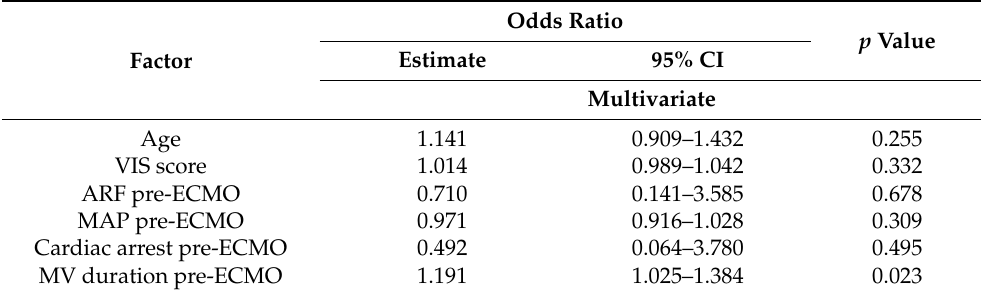
Table 5. Multivariate analysis of factors for hospital